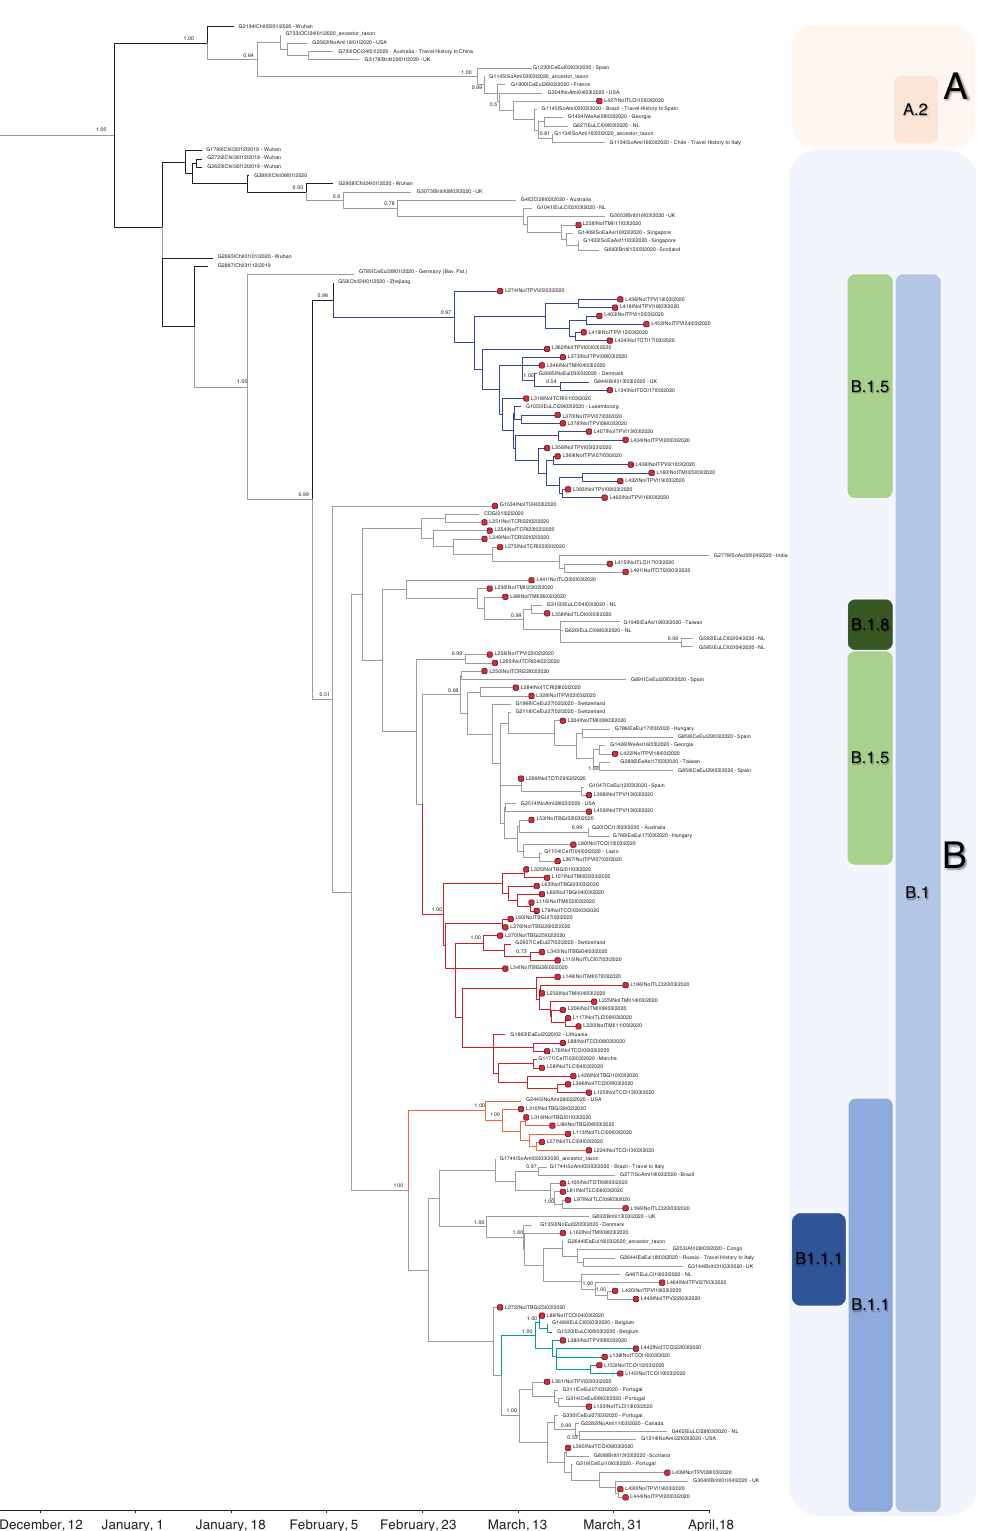
Fig. 5 Bayesian phylogeographic reconstruction incorporating location and travel history data of the most informative sequences for virus spread and clustering in Lombardy. SARS-CoV-2 genomes from Lombardy were shown by red circles. Local clusters of SARS-CoV-2 sequences supported by a posterior probability ≥ 0.98 by the time-scaled maximum clade credibility tree were highlighted in red ( A ), in blue ( B ), in cyan ( C ), and in orange ( D ). Two independent chains were run for 25 million states. Parameters and trees were sampled every 1000